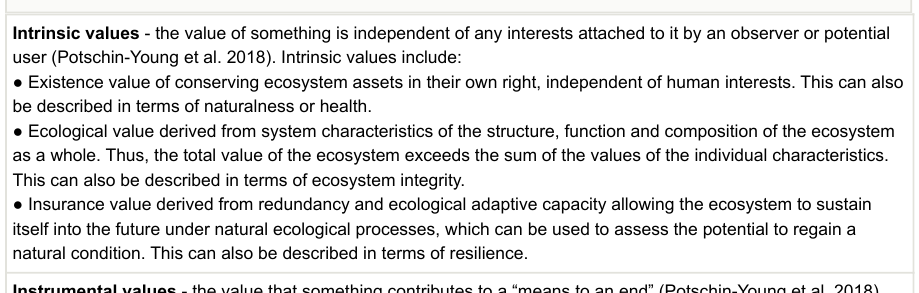
Definitions of the full suite of the axes from intrinsic to instrumental values and from ecocentric to anthropocentric